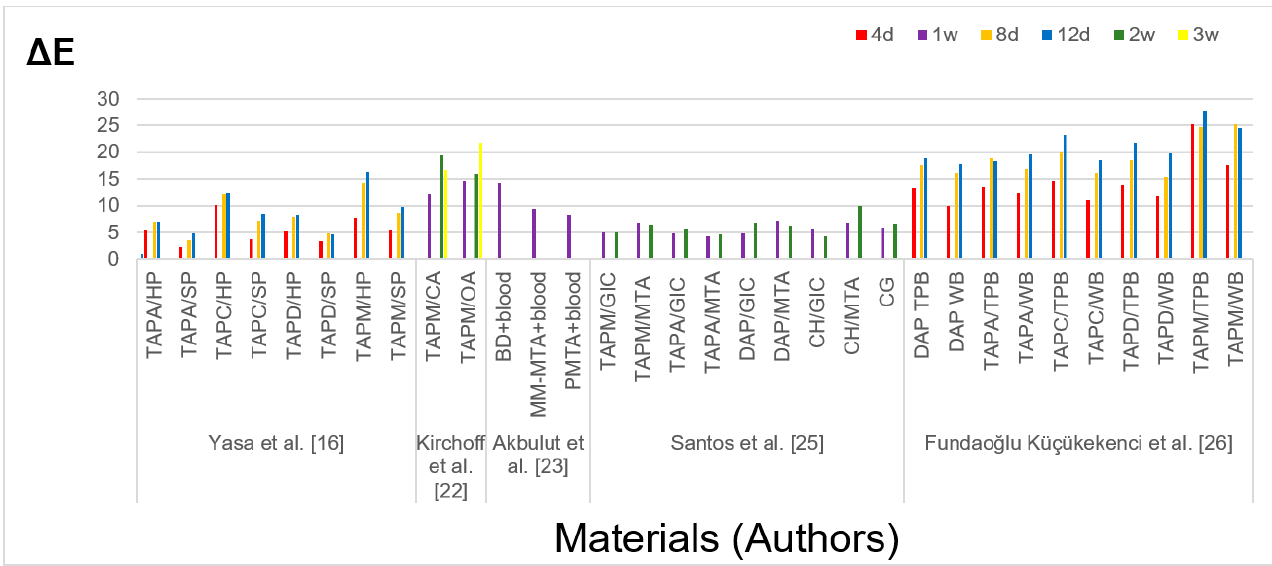
Figure 2. Delta E values defining the color changes of the tooth induced by bleaching materials reported in in vitro studies. Abbreviations: BD, Biodentine; CA, closed apices; CG, control group; d, day; DAP, double antibiotic paste; GIC, glass ionomer cement; HP, hydrogen peroxide; MTA, mineral trioxide aggregate; OA, open apices; PMTA, Pro Root MTA; SP, sodium perborate; TAPA, triple antibiotic paste with amoxicillin; TAPC, triple antibiotic paste with cefaclor; TAPD, triple antibiotic paste with doxycycline; TAPM, triple antibiotic paste with minocycline; TPB, thermo/photo bleaching; w, week; WB, walking bleaching; WMTA, white MTA.